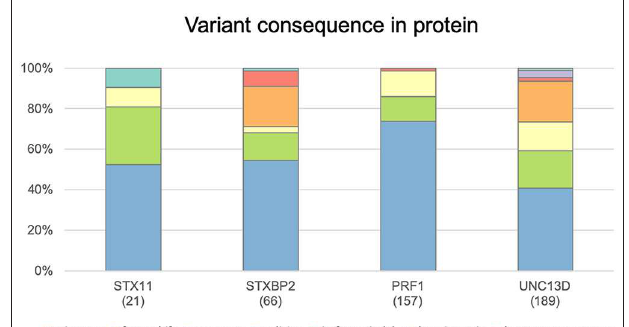
FIGURE 1 | Distribution of genetic variants according to their effect at the protein level. Histograms show the distribution of STX11, STXBP2, PRF1, and UNC13D variants included in FHLdb. The total number of variants reported in each gene is indicated within parentheses.